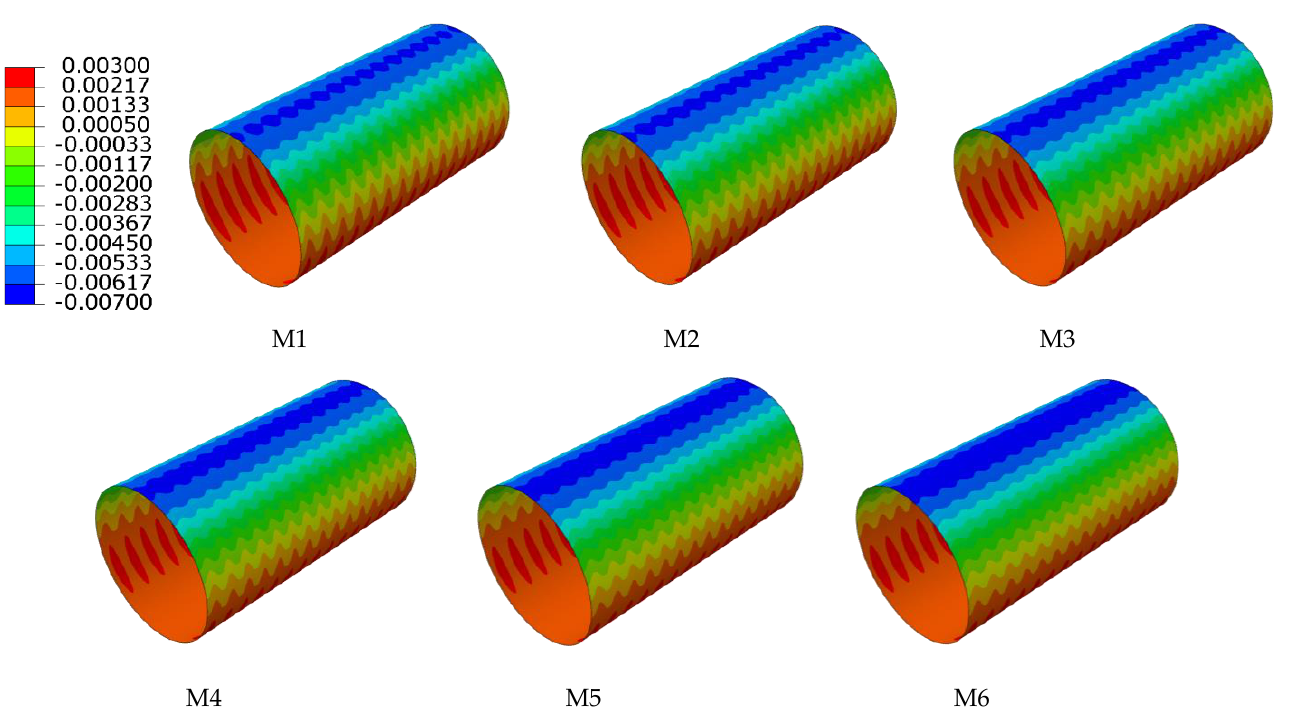
Figure 15. Radial displacement of interior wall.